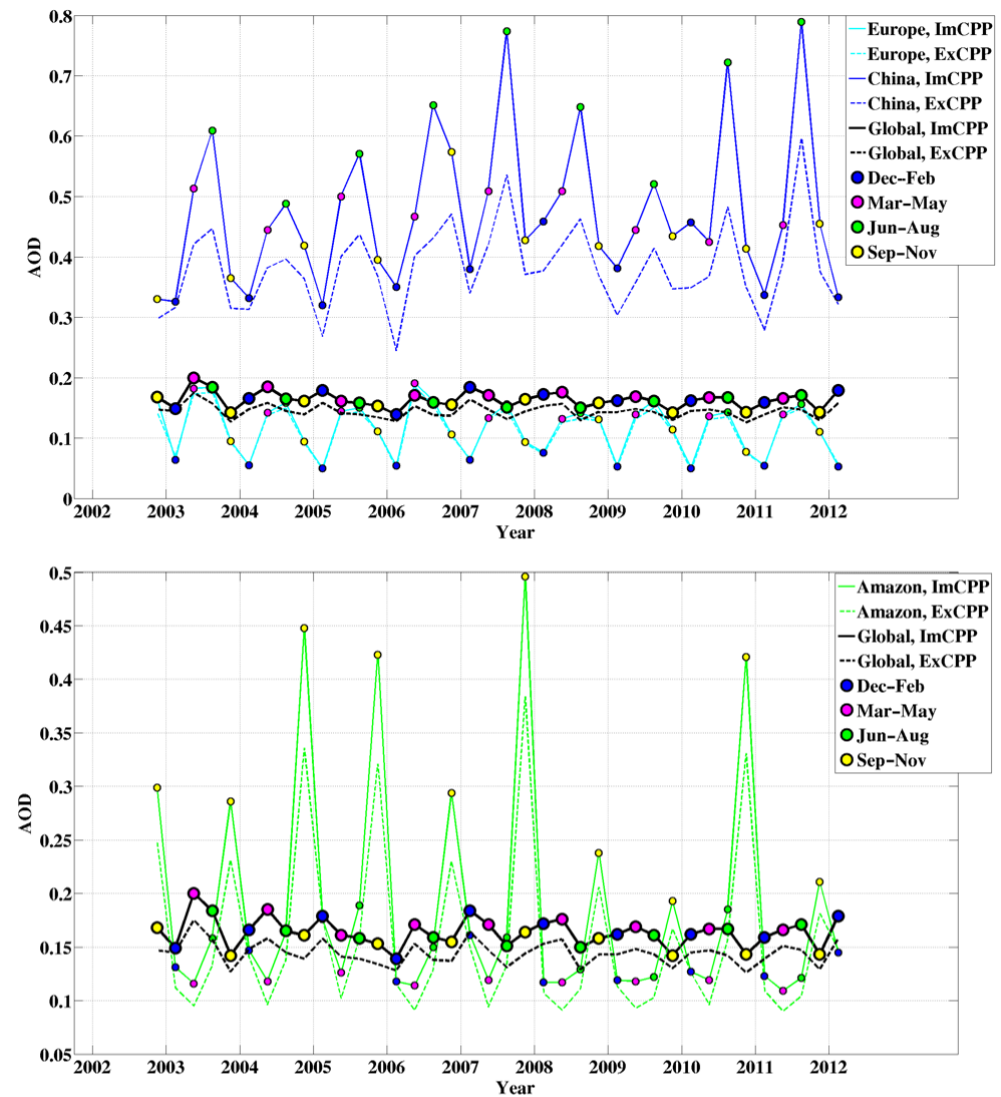
Figure 12. AATSR ADV AOD over land seasonal time series for the period 2002–2012 after application of the existing (dashed lines) and the improved CPP (solid lines) for different areas: Europe (light blue, upper panel), China (dark blue, upper panel) and Amazon (green, lower panel). Global AOD over land (black lines) is plotted on both panels, for comparison. Seasons are marked with coloured circles (see legend). Note the different AOD scales in each plot. For areas definition see Sect.